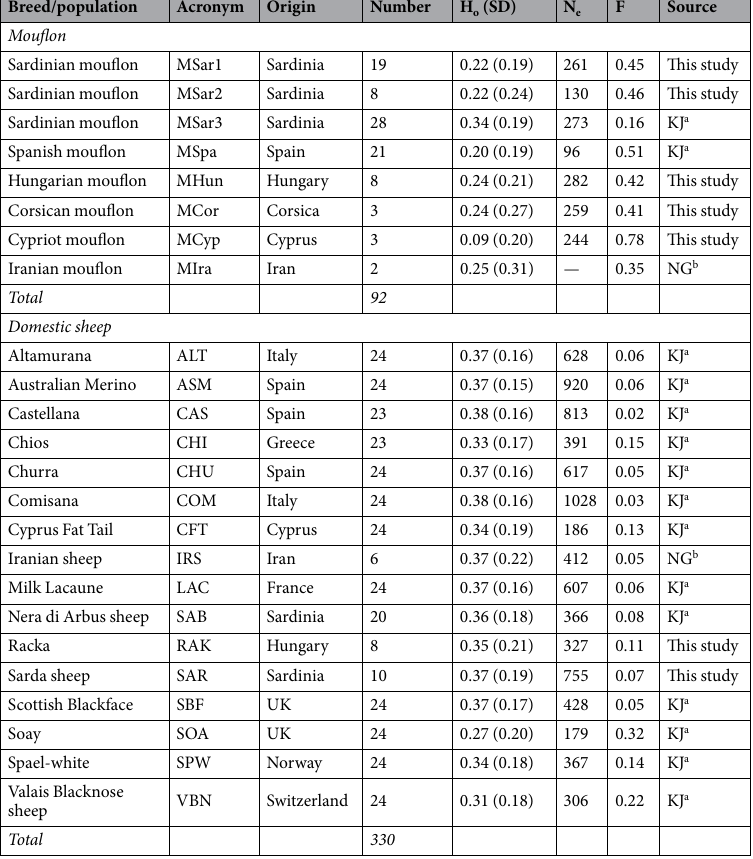
Table 1. Sample information and diversity indexes. Breed/population name and the corresponding code used throughout the manuscript, the country of origin and the number of individuals analysed in this work are shown in the first four columns, along with the observed heterozygosity ( H o ) and its standard deviation ( SD , in brackets), the effective population size ( N e ) and the inbreeding coefficient ( F ). a KJ refers to Kijas et al . 22 . b